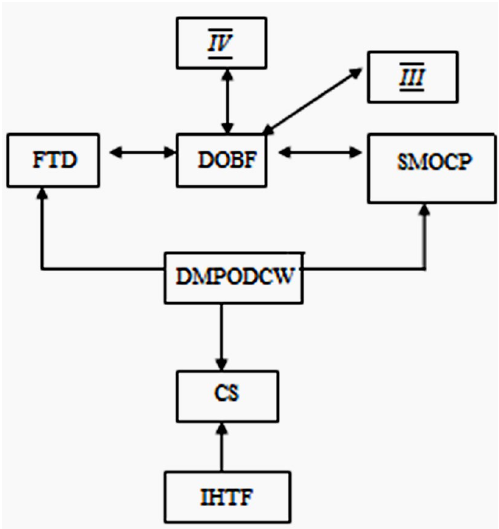
Fig. 4. Block diagram of the hierarchy level of the system analysis of the degreasing process of raw materials of animal origin